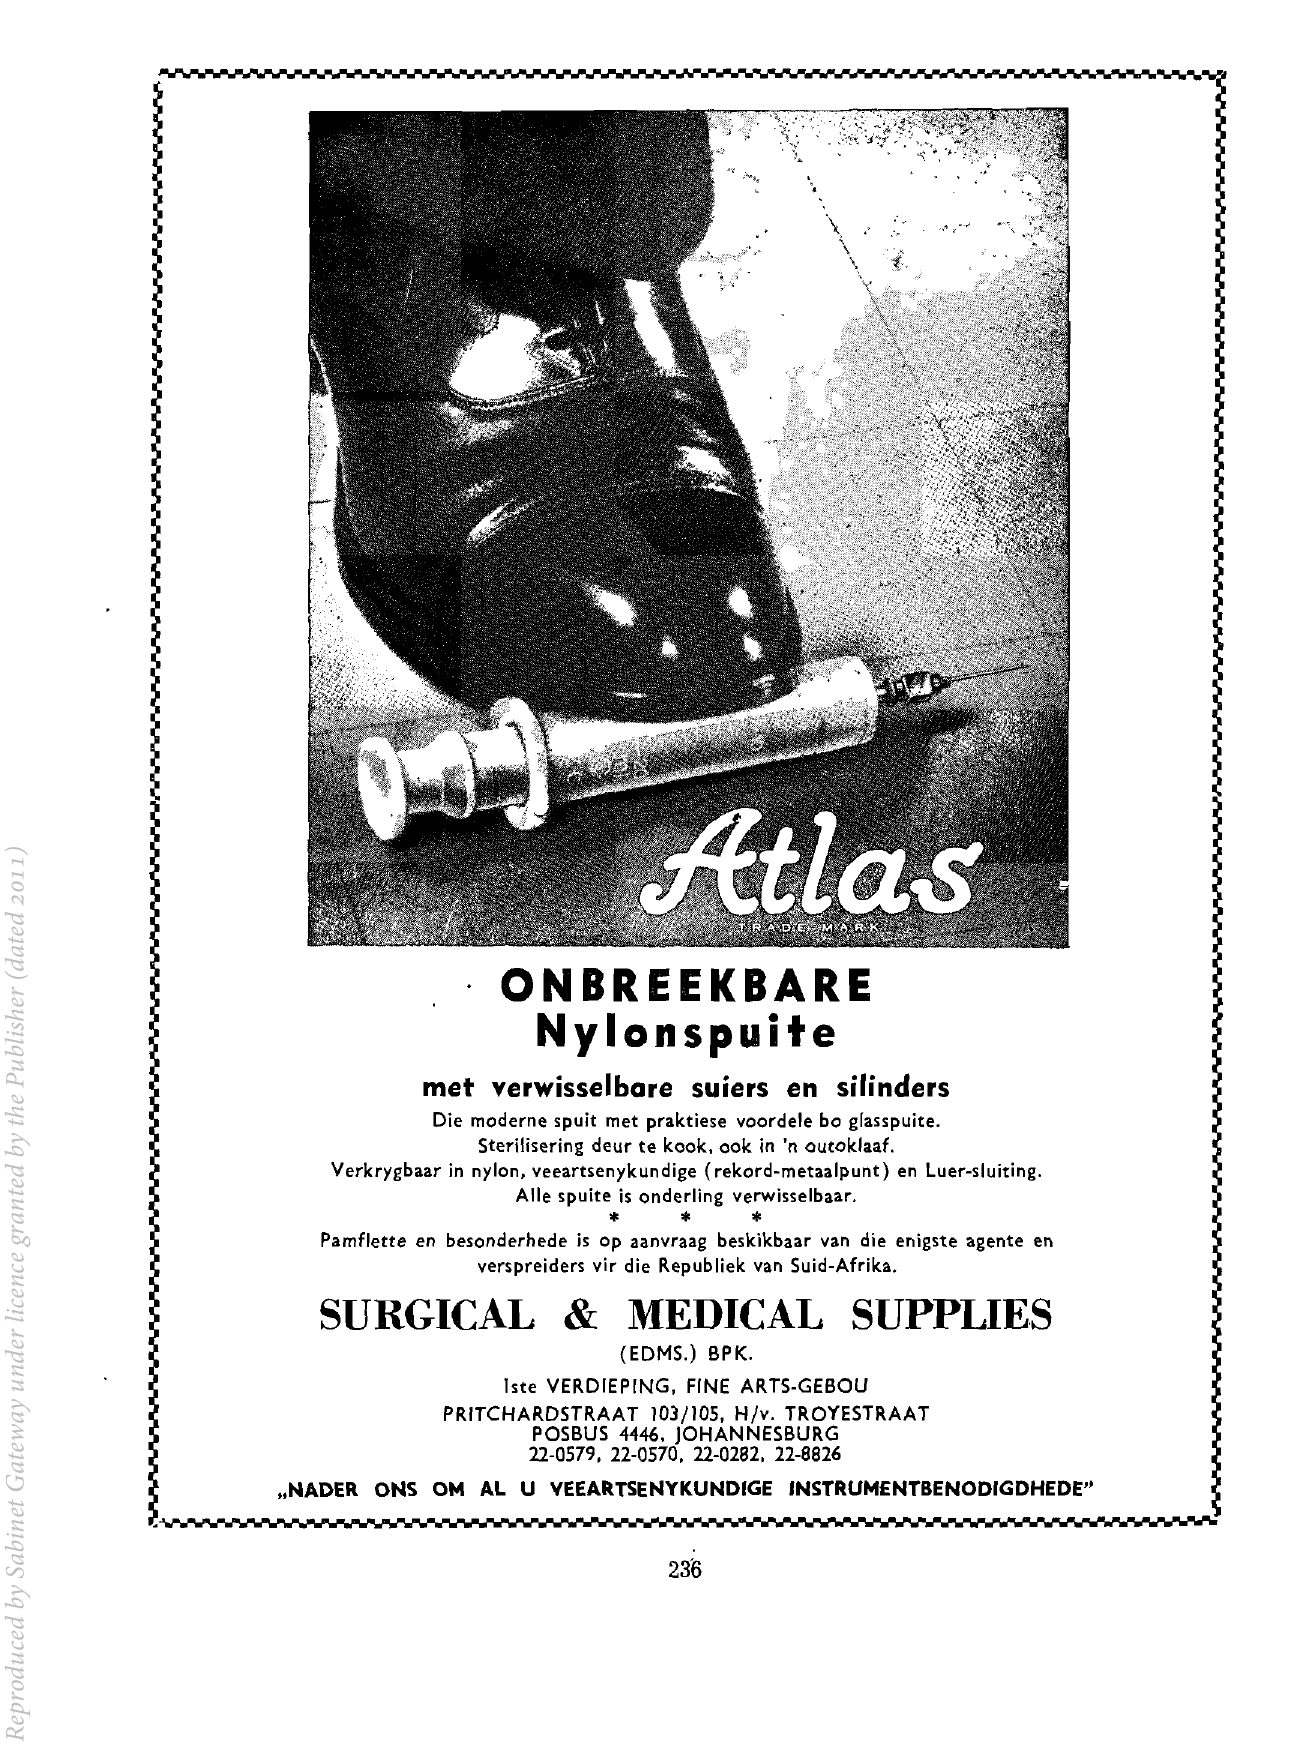
met verwisselbare suiers en